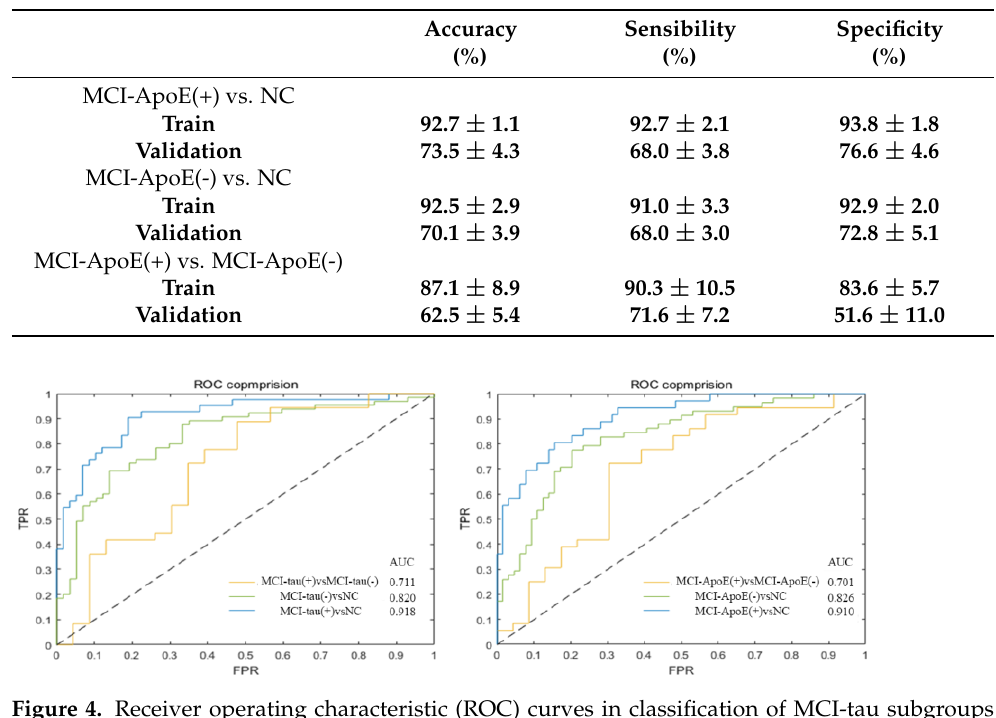
Figure 4. Receiver operating characteristic (ROC) curves in classification of MCI-tau subgroups and MCI-ApoE subgroups. [MCI-tau(+)-MCI-tau(-) AUC: 0.711 (0.668–0.805), MCI-tau(-)-NC AUC: 0.820 (0.752–0.907), MCI-tau(+)-NC AUC: 0.918 (0.829–0.955)]; [MCI-ApoE(+)-MCI-ApoE(-) AUC: 0.701 (0.632–0.747), MCI-ApoE(-)-NC AUC: 0.826 (0.788–0.853) and MCI-ApoE(+)-NC AUC: 0.910 (0.861–0.937)]. Data are given as median (interquartile range). TPR: True Positive Rate; FPR: False Positive Rate; AUC: Areas under the